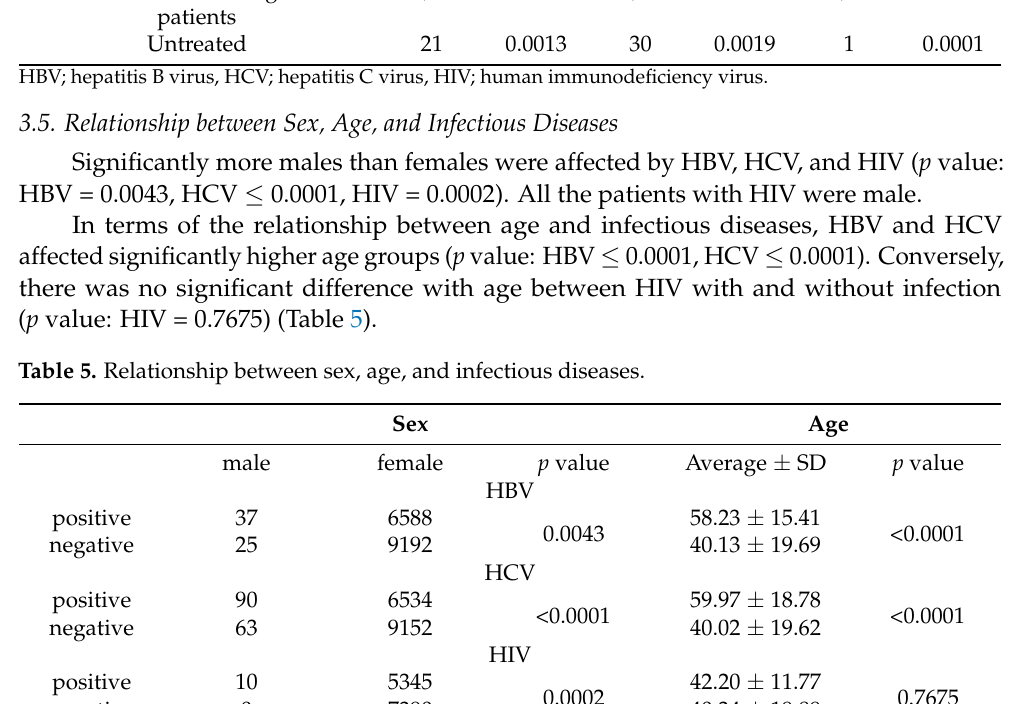
Table 4. Detection rate of untreated infectious disease patients by screening test. HBV